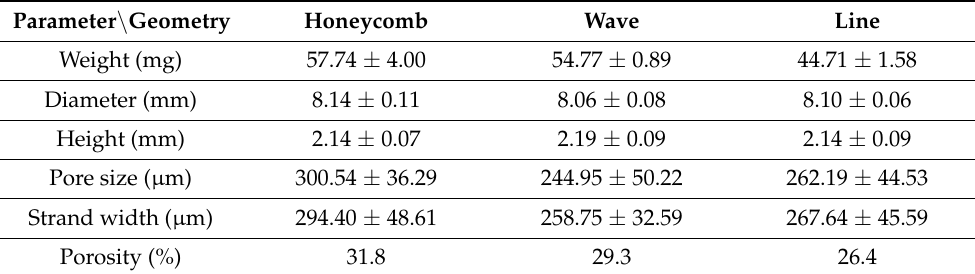
Figure 3. Comparison of round PCL scaffolds with variations in inner geometry: ( a ): lines; ( b ): waves; ( c ): honeycomb. Table 5. Dimensions and weight of the round PCL scaffolds.